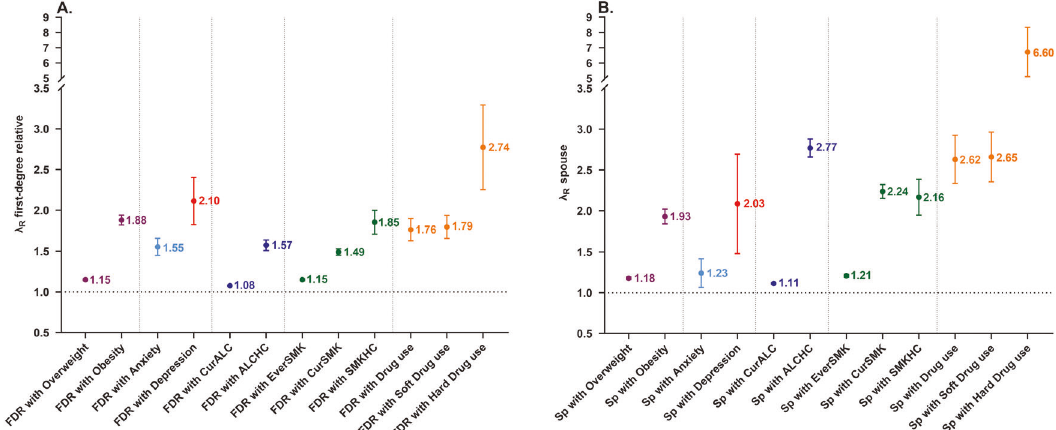
Fig. 1 Familial aggregation of obesity, anxiety, depression and substance use. A Familial aggregation of obesity, anxiety, depression and substance use among fi rst-degree relatives. B Familial aggregation of obesity, anxiety, depression and substance use among spouse. FDR, fi rst-degree relatives; Sp, spouse; CurALC, current drinker; ALCHC, alcohol high consumption: daily alcohol intake ≥ 15 grams; EverSMK, ever smoker; CurSMK, current smoker; SMKHC, tobacco high consumption: smoking ≥ 20 cigarettes per day. λ R estimates adjusted for age, age 2 and sex.